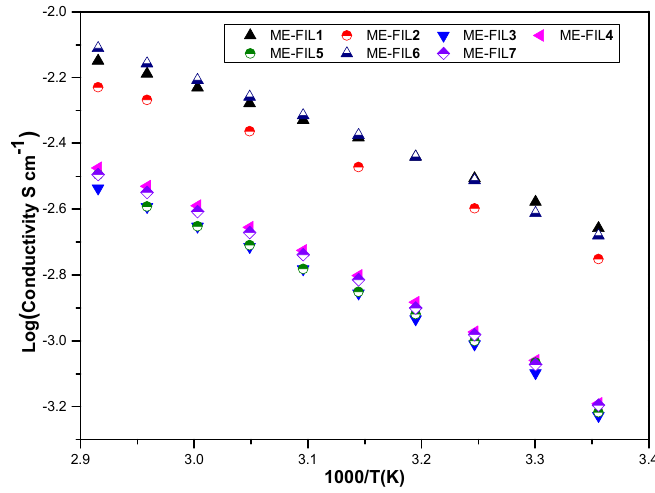
Figure 3. Arrhenius plots of ion conductivity for typical ME-FILs.